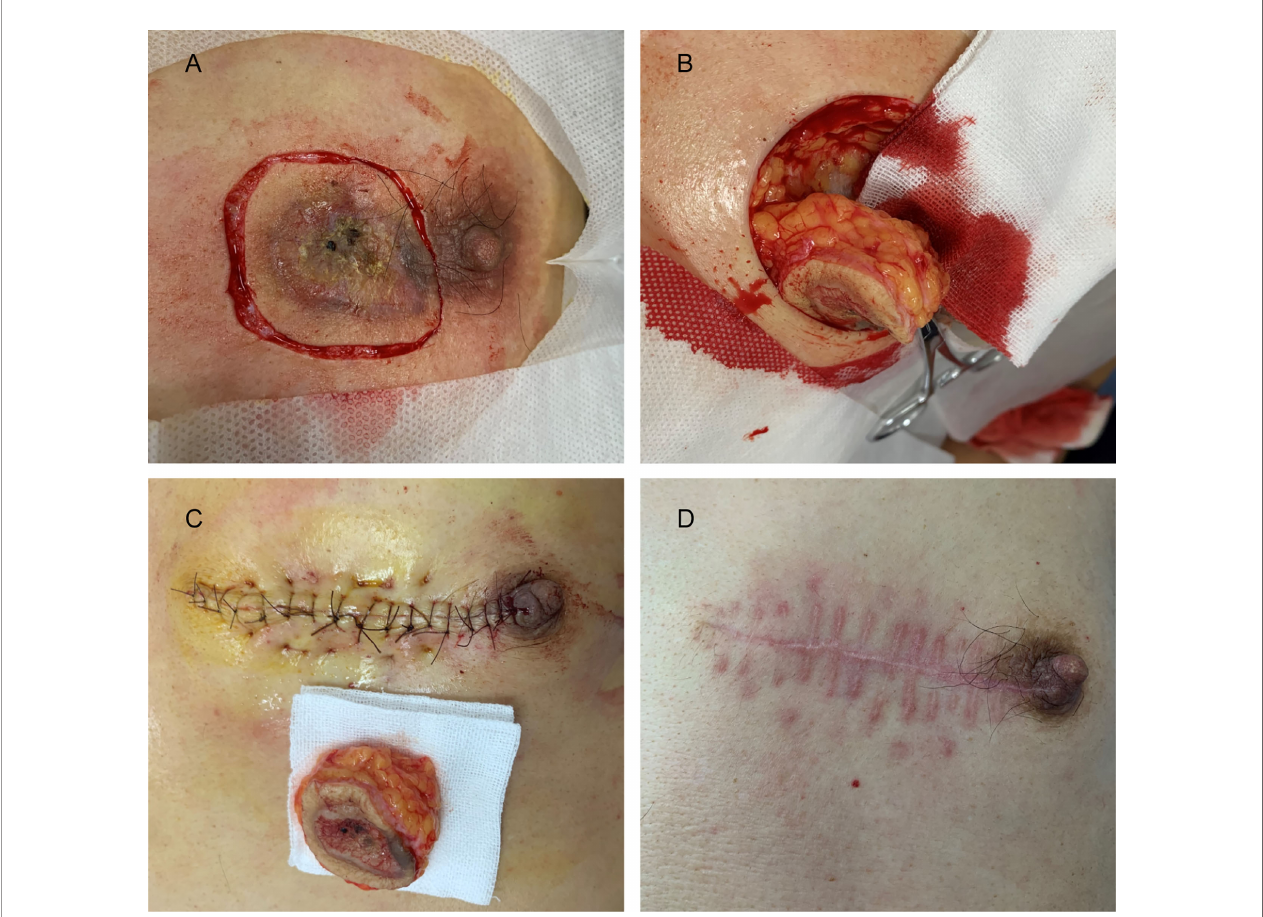
FIGURE 5 | (A) The margin of the skin lesion was expanded by 0.5 cm to demark the resection area. (B) The resection reached the deep layer of the super fi cial fascia. (C) Image taken immediately after LBD tension-reduced suturing was completed. (D) Three months after